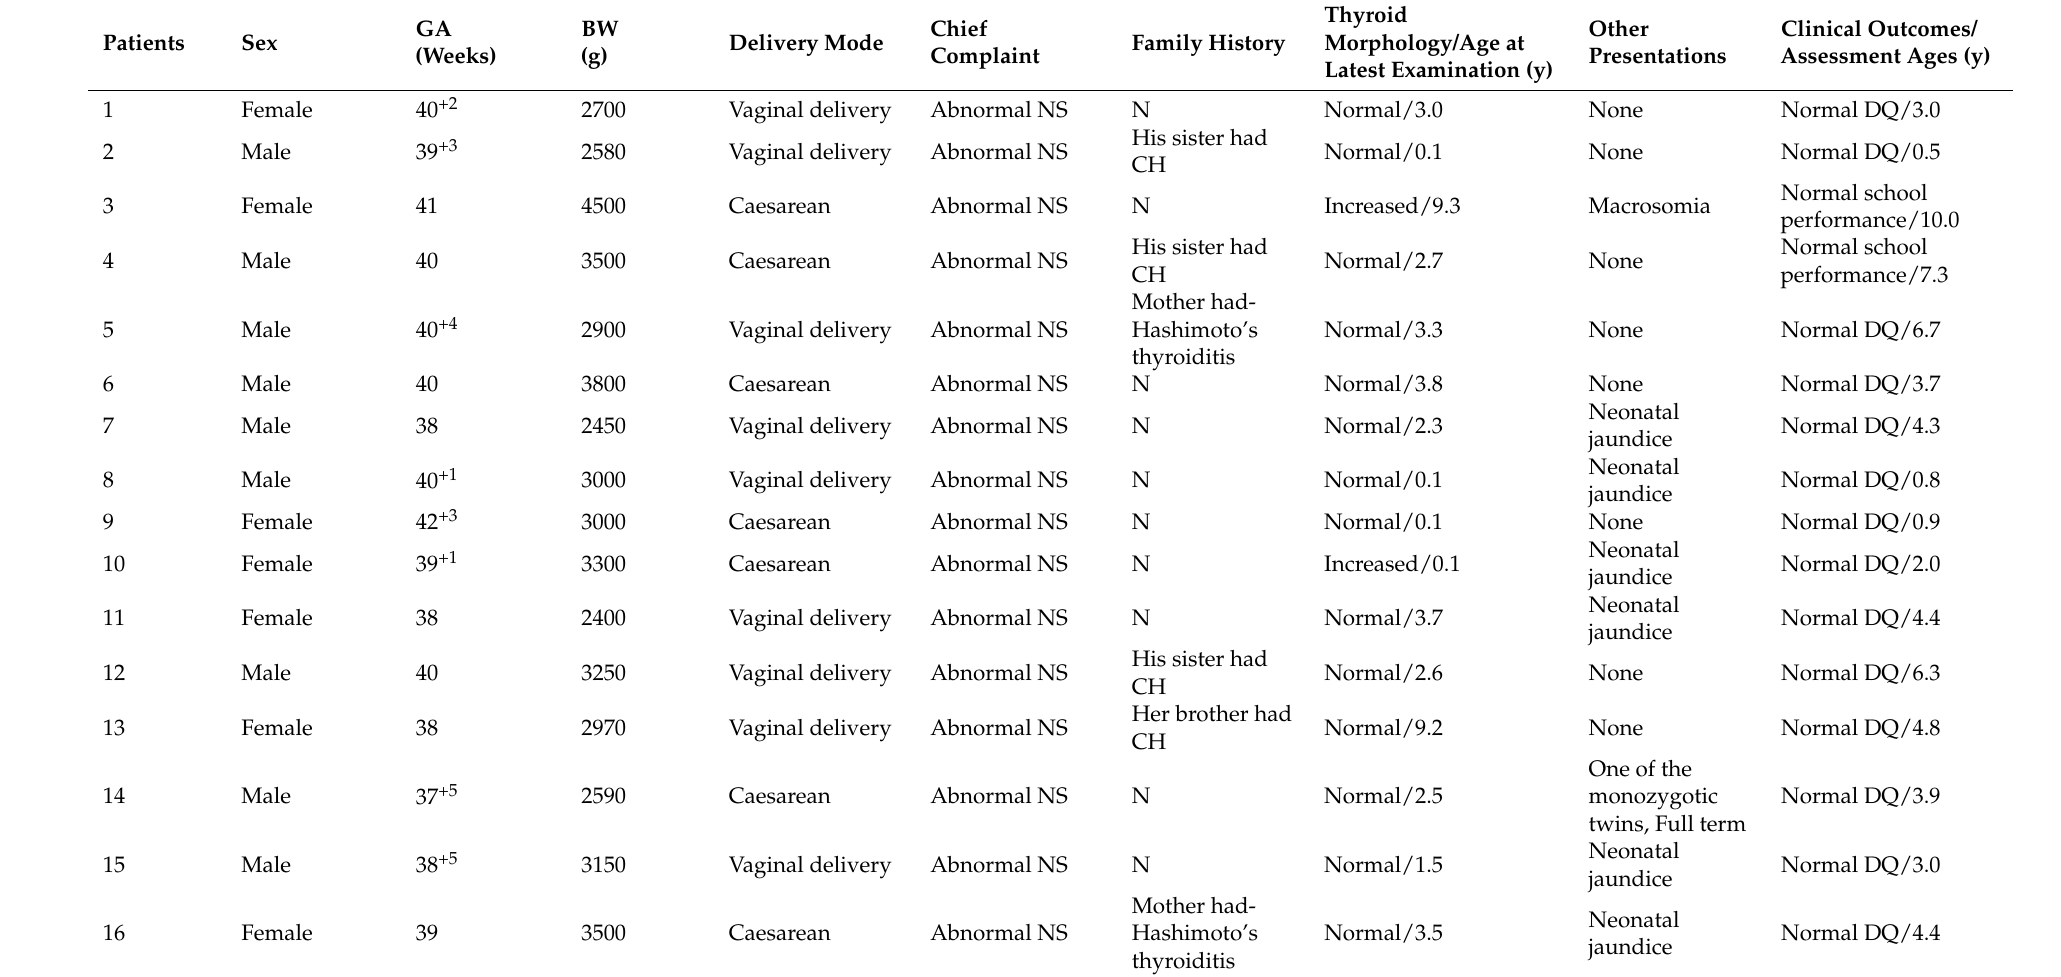
Table 2. Clinical information of the 33 CH